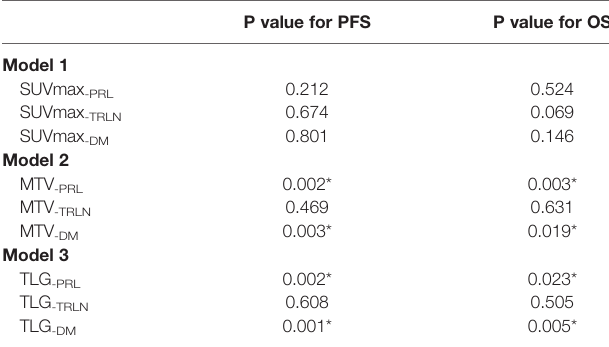
TABLE 5 | Multivariate analysis of PET parameters derived from different regional